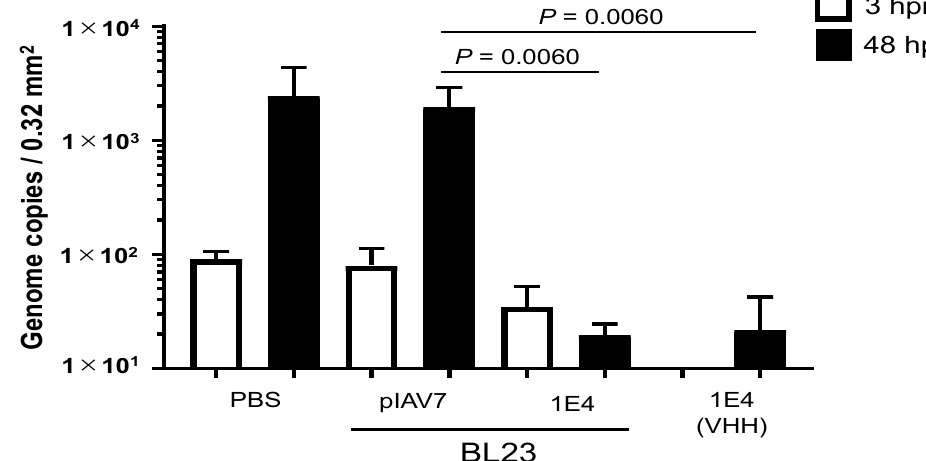
Figure 2. Neutralization of norovirus GII.17 in vitro by 1E4 nanobody-displaying Lactobacillus (BL23-IE4).We incubated 2 × 10 6 genome equivalents of GII.17 (Kawasaki 308) human norovirus with 3 × 10 6 cells of L. paracasei BL23-pIAV7 or BL23-1E4 or with 5 µg of recombinant VHH 1E4 for 2 h before using them to inoculate human intestinal epithelial cells. After inoculation, the cultures were incubated for 48 h in the presence of bile. Each data point is representative of at least three independent experiments, and data are shown as the mean ± 1 SD of six wells of supernatant from each culture group.